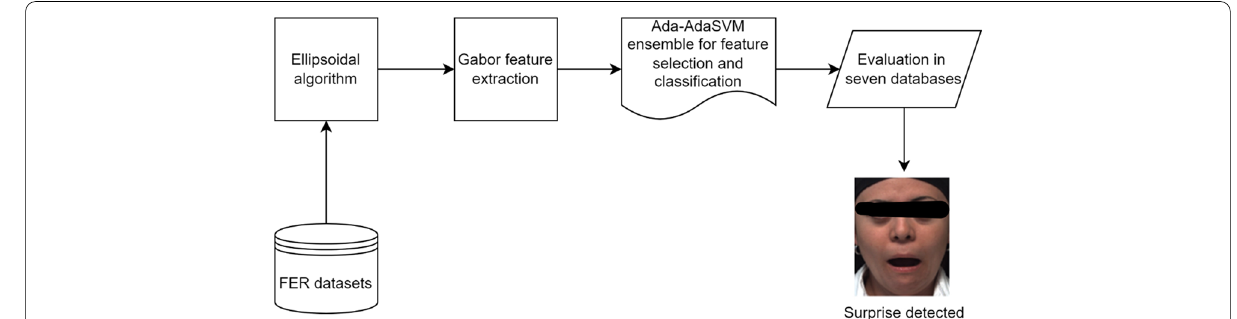
Fig. 1 Architectural framework of this study